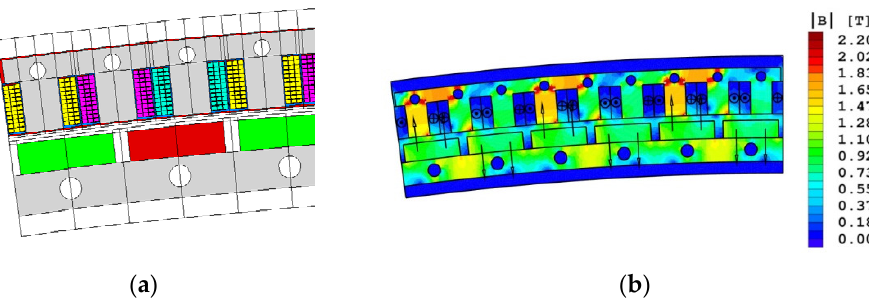
Figure 9. ( a ) FEMAG-DC model considering to the insulation; ( b ) The flux density distribution calculated by FEMAG-DC.